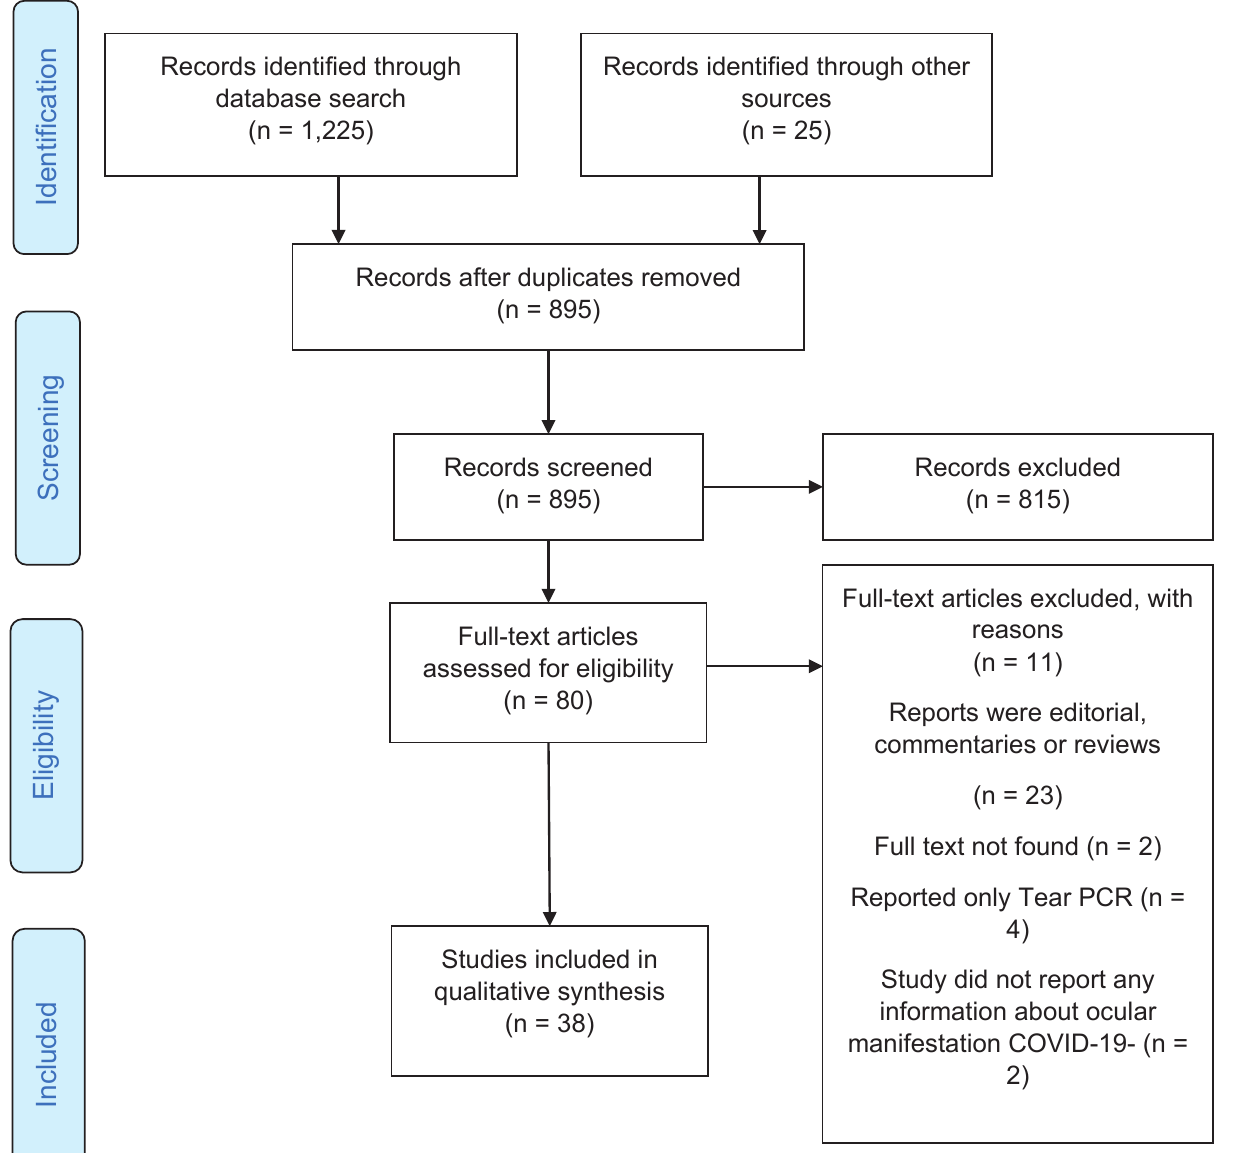
Figure 1. Flowchart of studies included in the systematic review of COVID-19 ocular manifestation Other rare conditions such as keratitis ( n = 2, 2.2%), episcleritis ( n = 2, 2.2%), keratoconjunctivitis ( n = 2, 2.2%), hordeolum ( n = 2, 2.2%), pingueculitis ( n = 1, 1.1%), posterior ischemic optic